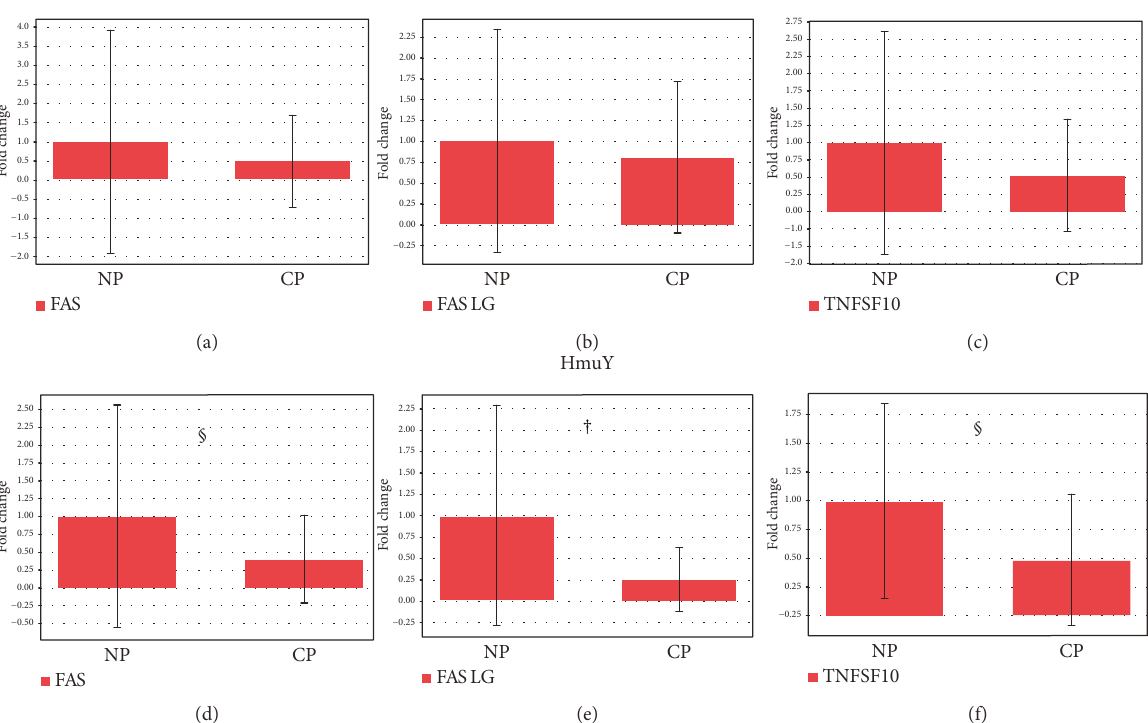
Figure 2: Apoptosis-related extrinsic pathway gene expression in the PBMC of the (a-c) P and NP groups without stimuli and under (d-f) P. gingivalis HmuY protein stimulation. (a, d) FAS (TNF receptor superfamily, member 6); (b, e) FAS LG (TNF superfamily, member 6 ligand); (c, f) TNFSF10 (tumor necrosis factor ligand superfamily-10). † p = 0 01 and § p < 0 1